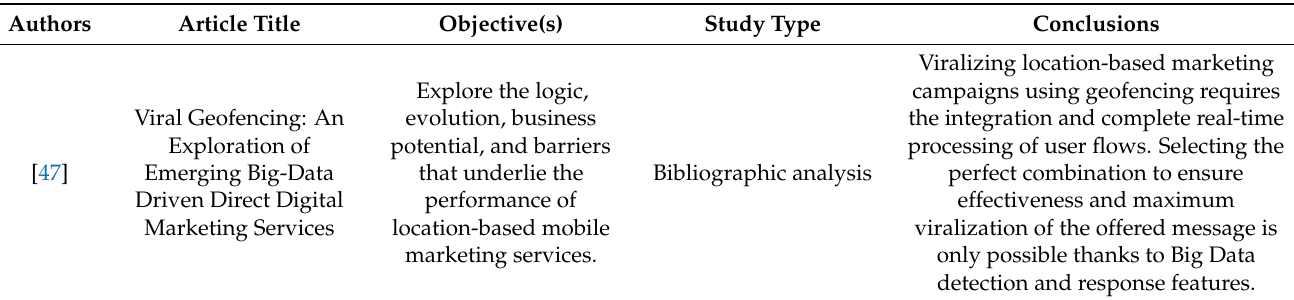
Table 1. Relevant Studies list resulted from step 3